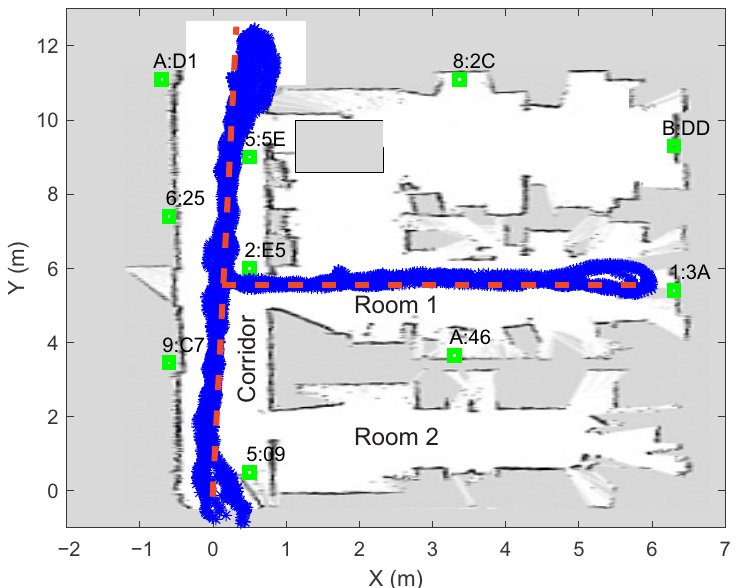
Figure 3. Locations of BLE beacons (green squares) and walked path (determined with the visual- inertial SLAM) during automated measurement capture. The ground truth path is marked with the red dashed line. The white pixels represent empty space and grey pixels represent occupied